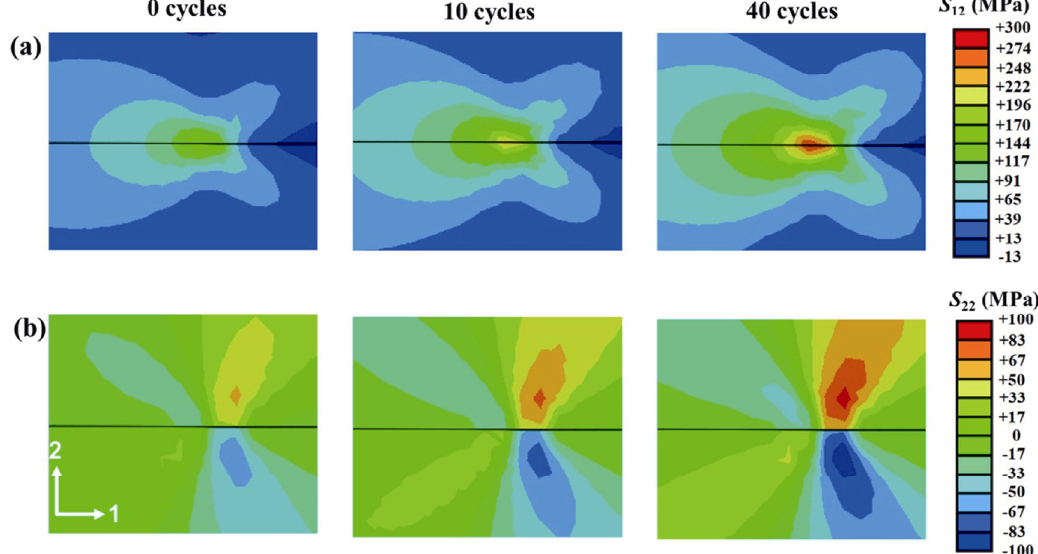
Fig. 34 Evolution of stress at the crack tip with temperature: (a) shear stress and (b) normal stress. Reproduced with permission from Ref. [168], © Published by Elsevier Ltd on behalf of The editorial office of Journal of Materials Science & Technology